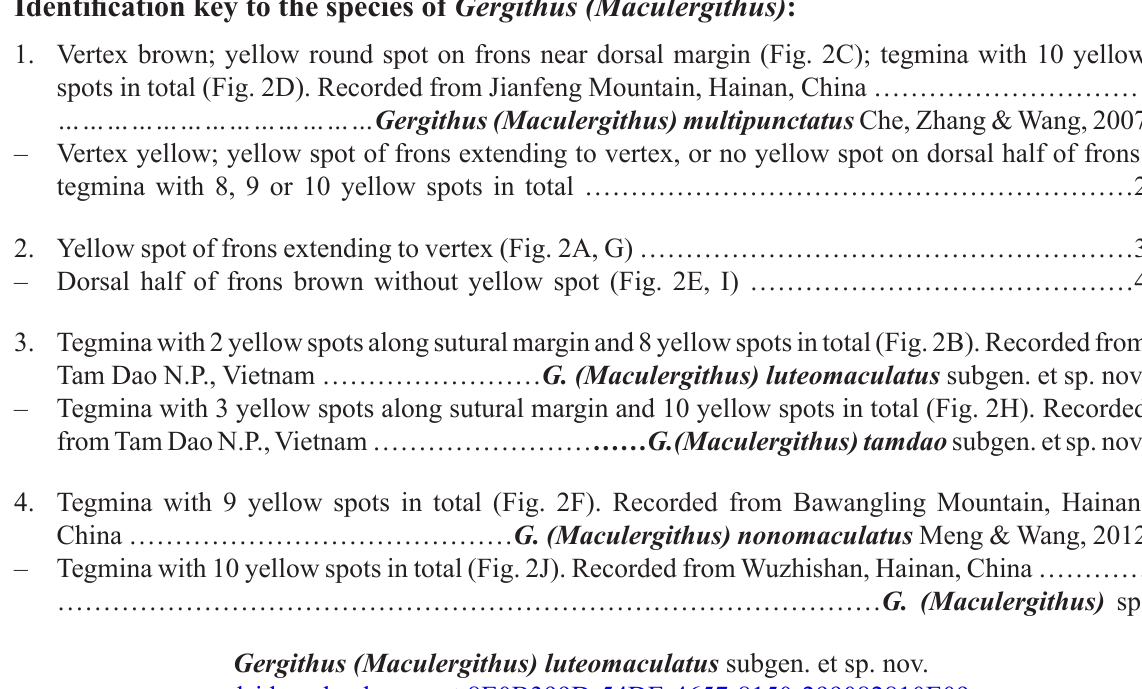
The species can be recognized by the following combination of characters: (1) frons with a yellow spot along dorsal margin; (2) vertex yellow; (3) 2 yellow spots on tegmina along sutural margin; (4) tegmina with 8 yellow spots in total. Etymology The species epithet is formed by the juxtaposition of luteus (adj., Latin) = yellow and maculatus (adj., Latin) = spotted. It refers to the yellow spots on the mesonotum and tegmina of the species. Type material Holotype VIETNAM: ♂ (dissected, Fig. 3): [Coll. I.R.Sc.N.B., Vietnam, Tam Dao N.P., 25–30.vii.2011, day